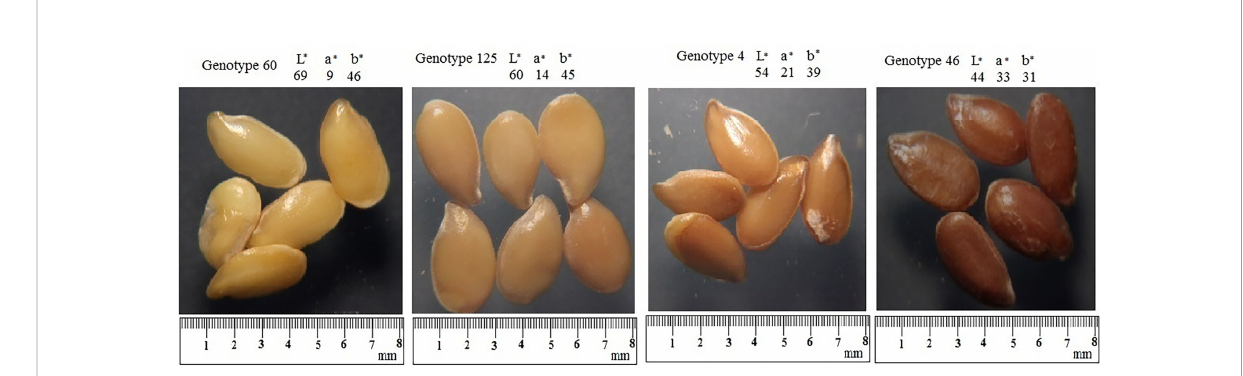
FIGURE 4 Four seed color types in the fl ax collection used and their L*, a*, and b*